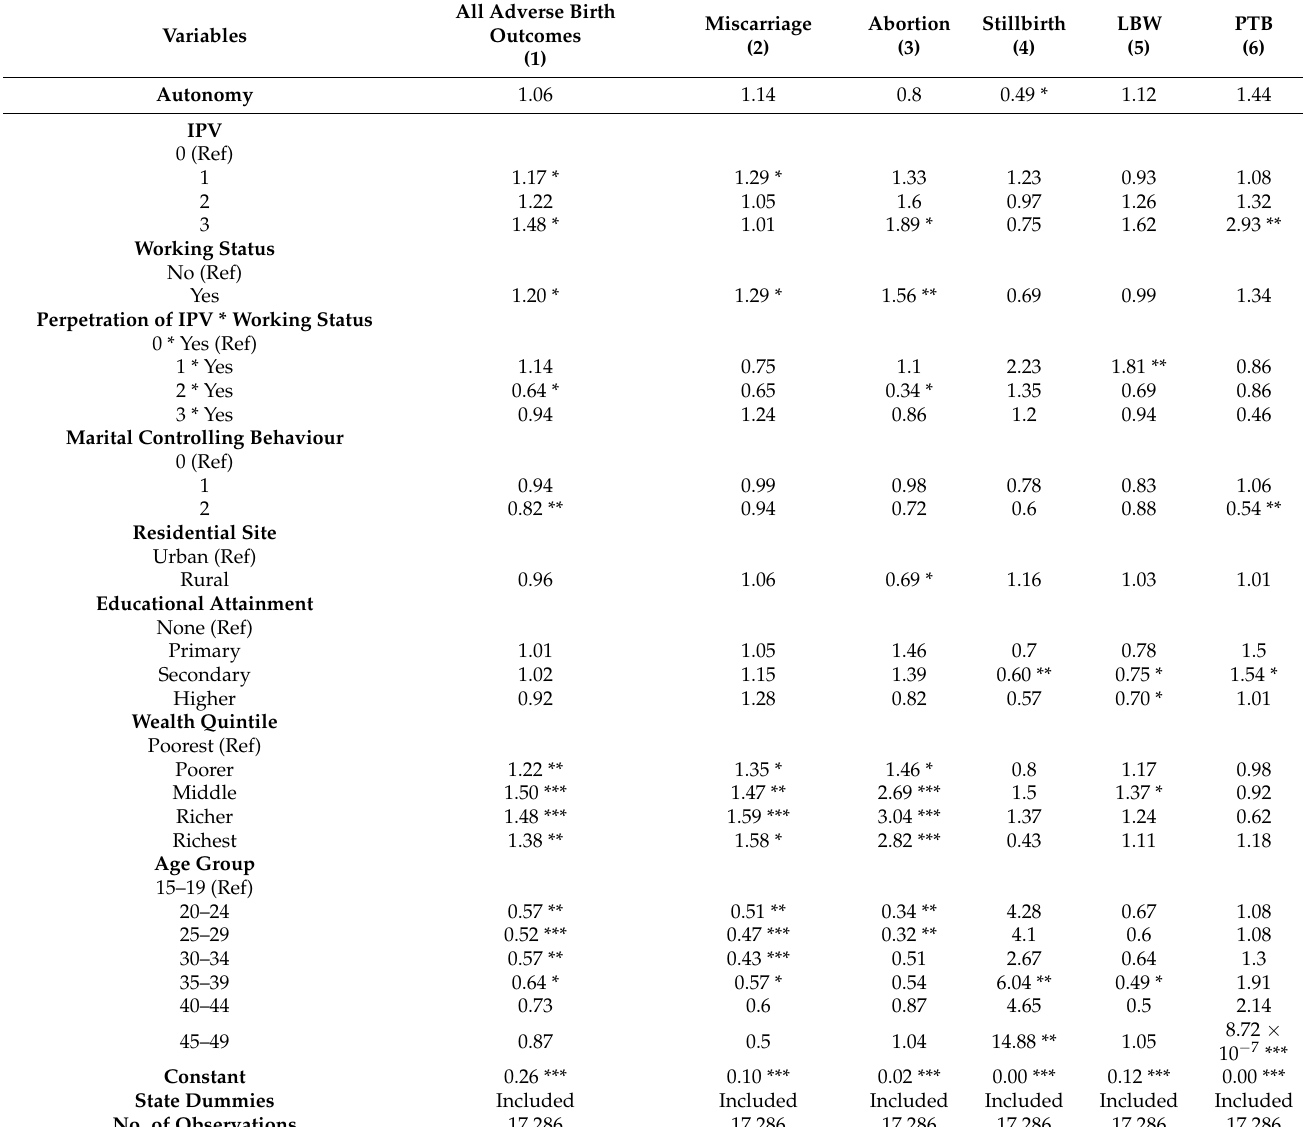
Table 3. Estimation Results for adverse birth outcomes #